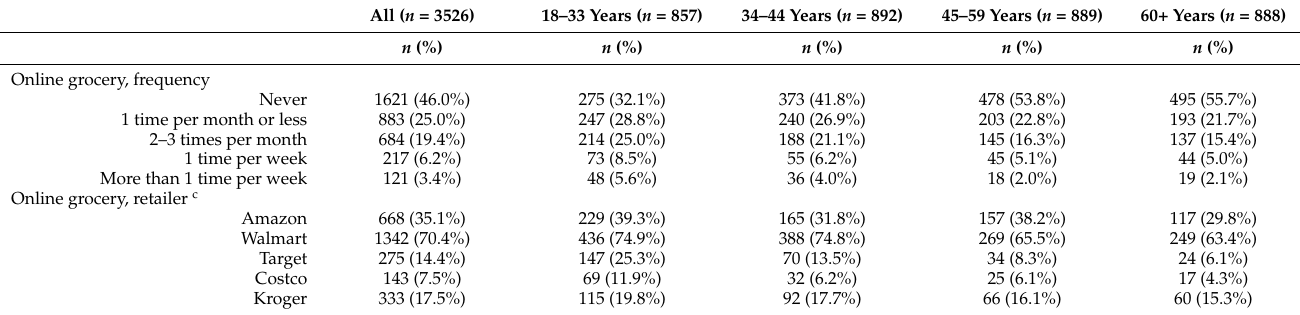
Table 2. Grocery shopping behaviors and attitudes: a overall and by age group b